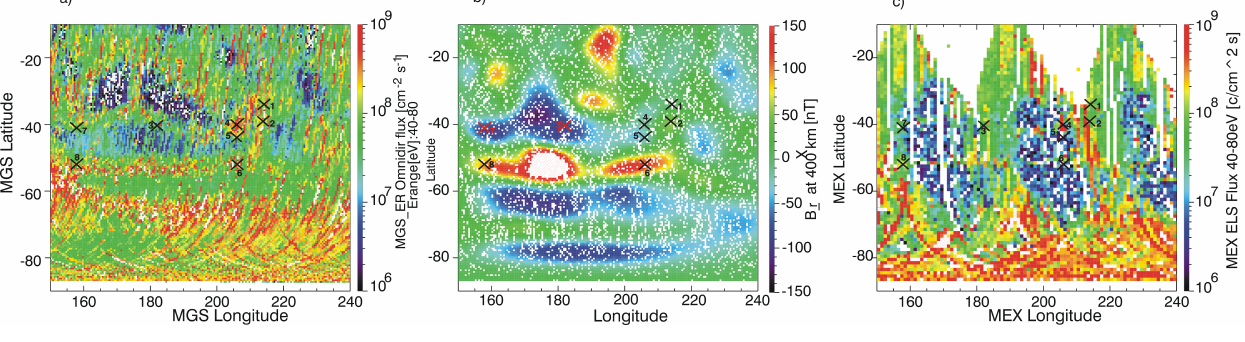
Fig. 13. (a) Precipitation patterns of maximum fluxes of the electrons with 30 <E e < 80eV measured on MGS at h ∼ 400km, (b) vertical component of the crustal magnetic field, (c) precipitation pattern of the electrons with 40 <E e < 80eV measured on the MEX spacecraft at 250 ≤ h ≤ 600km. Positions of aurora events observed by SPICAM viewing in the nadir are shown by